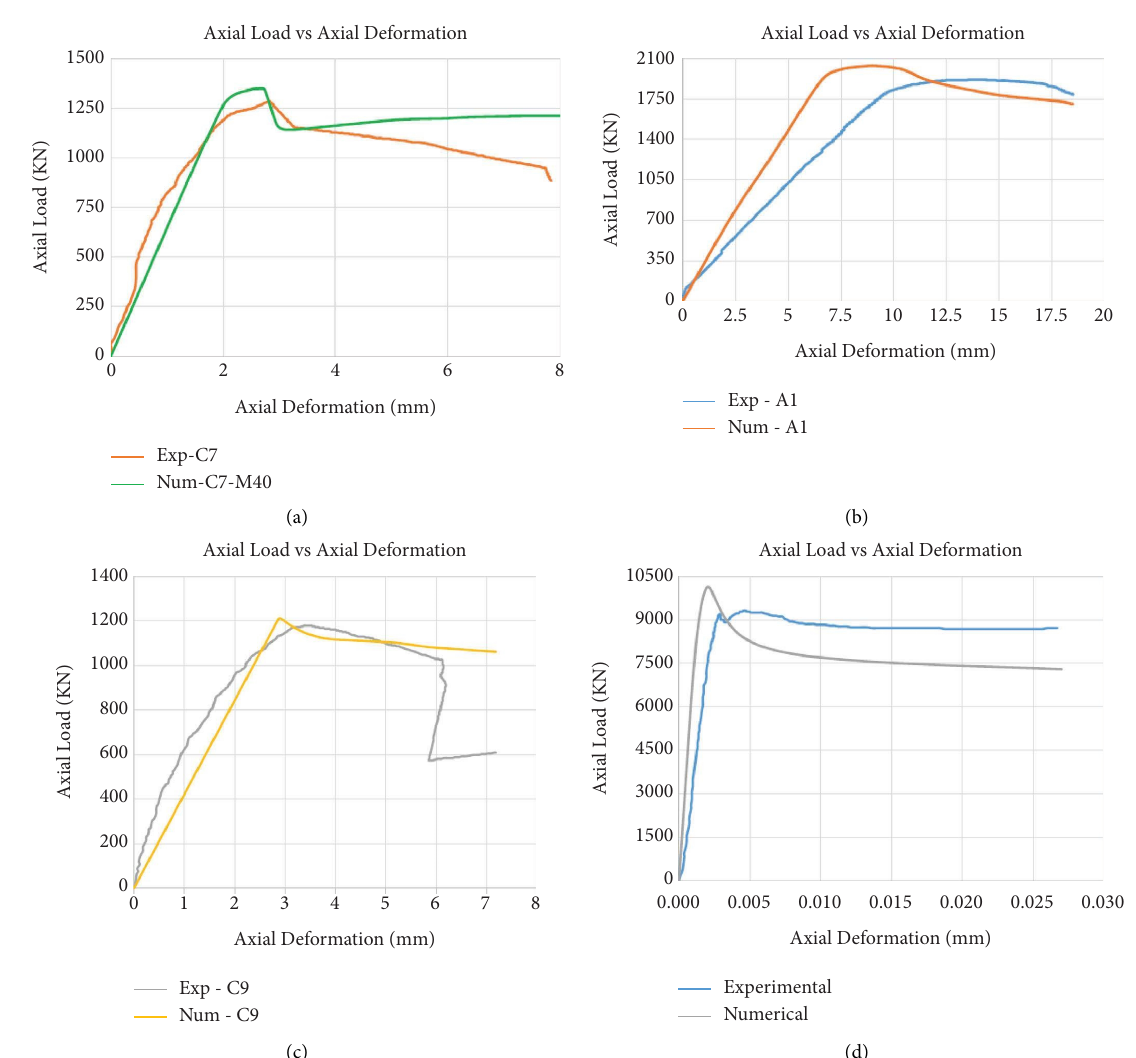
Figure 4: Axial load vs. axial deformation curve for (a) A1 [4]; (b) C7 [14]; (c) C9 [14]; (d) S690-C90-SP60-H